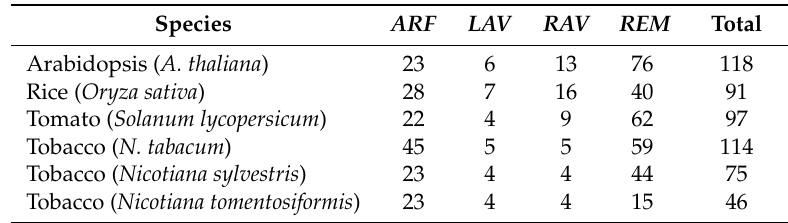
Table 2. Summary and classification of the B3 superfamily members identified in the genome of Arabidopsis, rice, tomato, and